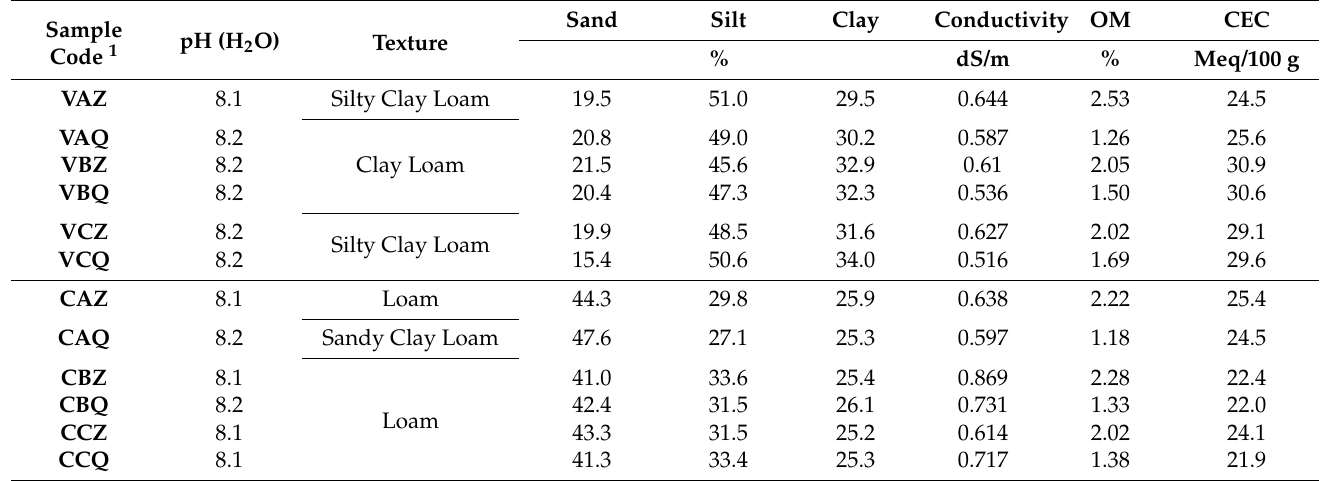
Table 2. Summary of main physico-chemical characteristics of the soils under experiment, analysis protocols by Italian Official Gazzette n ◦ 248 [43].